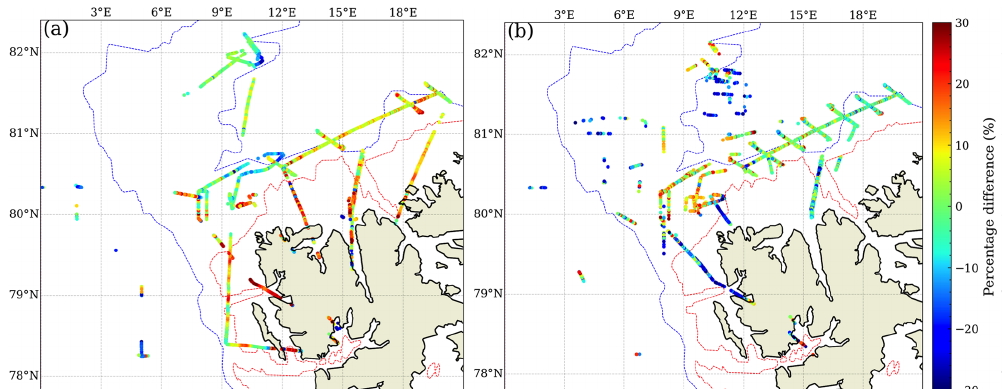
Figure 7. A map illustrating the percentage difference between the RTM–SciML estimated broadband albedo and the albedo measured in situ using (a) the “SMART” albedometer and (b) the pyranometer. To choose the matching MODIS retrieval, a tight time constraint of 1.5h ( δ t ≤ 1 . 5h) was applied. On the right, the color bar indicates the scale of the percentage difference value for each pixel ( Additionally, dashed red and blue lines represent the 200 and 1000m isobaths, respectively. Each flight segment’s dates are listed in Fig.